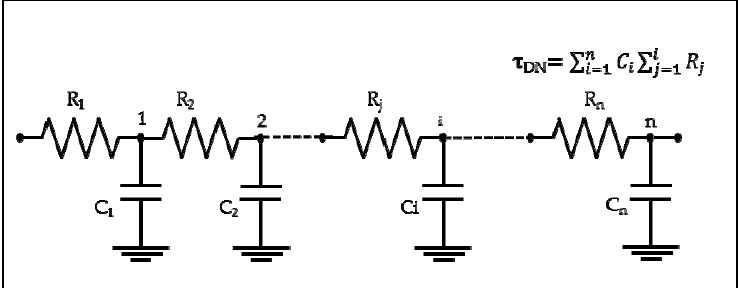
Figure 3. Wire delay model—Elmore Delay formula.